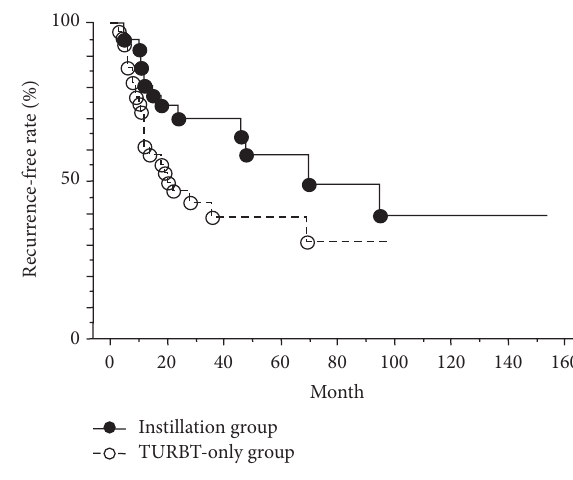
Figure 2: Comparison of recurrence-free survival between Instil- lation group ( e ) and TURBT-only group ( I ). Recurrence-free rate wassignificantlyhigherintheInstillationgroupthanintheTURBT- only group ( 𝑝 = 0.04 ). The 1-, 3-, and 5-year recurrence-free rates were 80.6%, 69.7%, and 58.5% for the Instillation group and 61.2%, 43.4%, and 38.6% for the TURBT-only group.